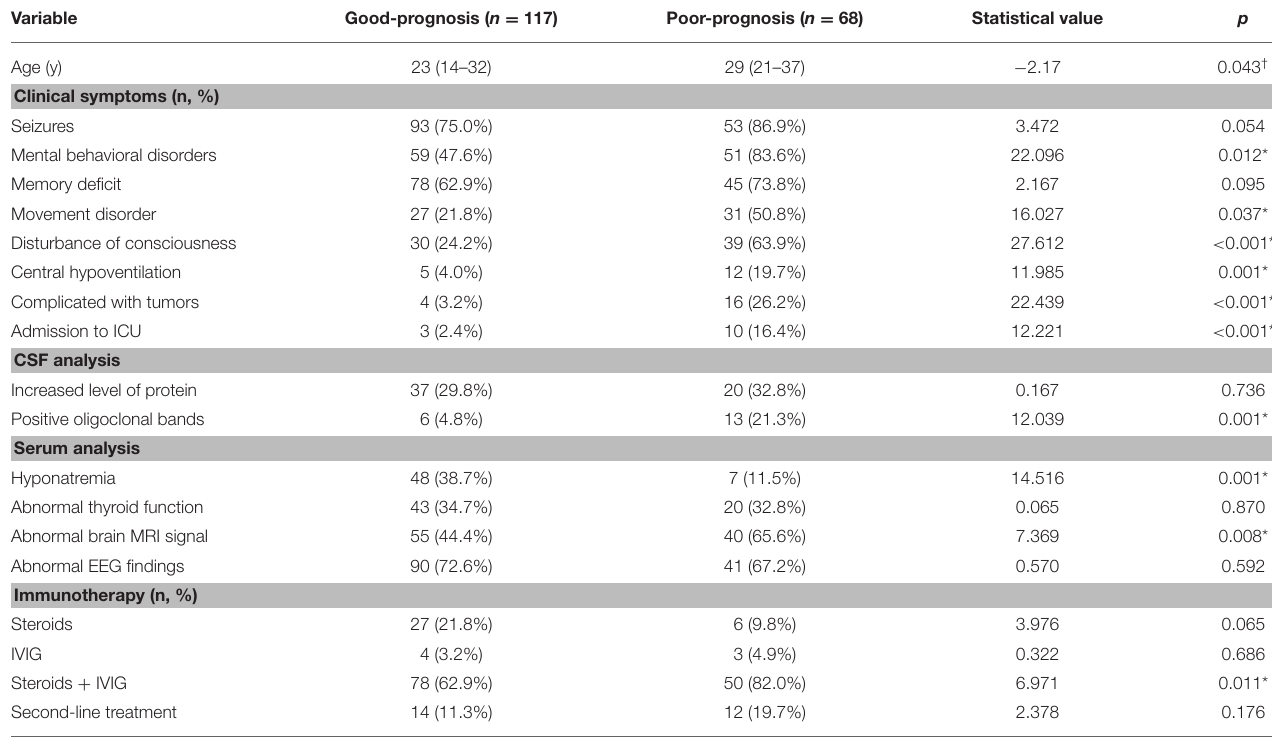
TABLE 4 | Results from the univariate analysis of clinical data of two